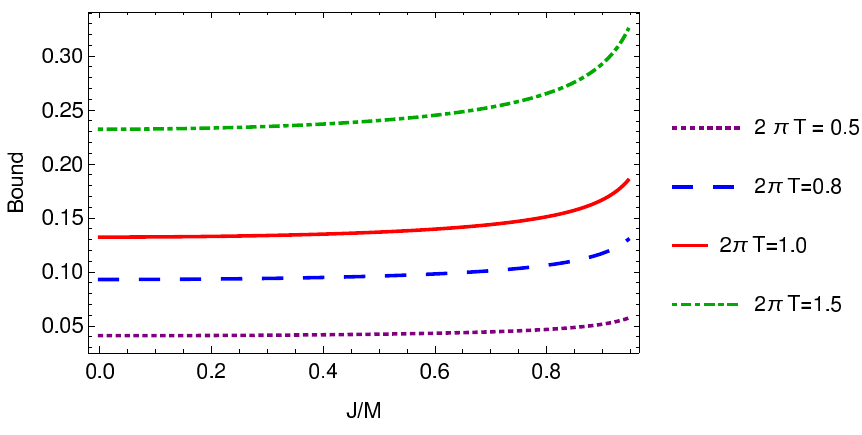
Figure 8 . Bound on N send using eq. (4.22), assuming momentum is sent spherically over transverse space at (cid:12)xed temperatures. We (cid:12)xed h = 1, (cid:1) = 0 : 6, t 0 = 0, t f =